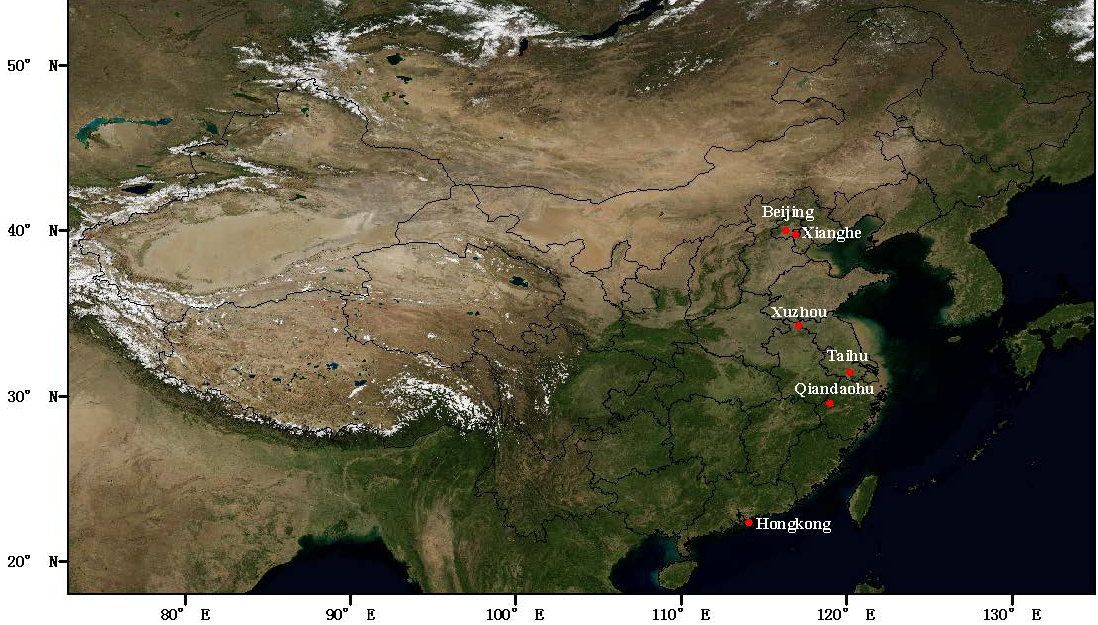
Figure 1. Geographic location of the six typical Aerosol Robotic Network (AERONET) sites in